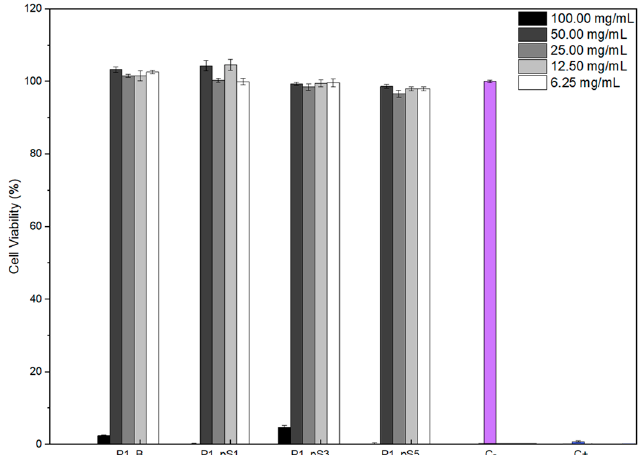
Figure 7. Cell viability studied using resazurin assays to assess the structures’ cytotoxicity effect on a Saos-2 (primary osteogenic sarcoma) cell line using the extract dilution exposure method, after 48 h of cell exposure to the scaffolds’ extracts: scaffolds without pSPIONs (P1_B), scaffolds containing 1.92 wt.% of pSPIONs (P1_pS1), scaffolds containing 3.77 wt.% of pSPIONs (P1_pS3), and scaffolds containing 5.54 wt.% of pSPIONs (P1_pS5); A positive control (C+) using dimethyl sulfoxide (blue) and negative control (C − ) (purple).